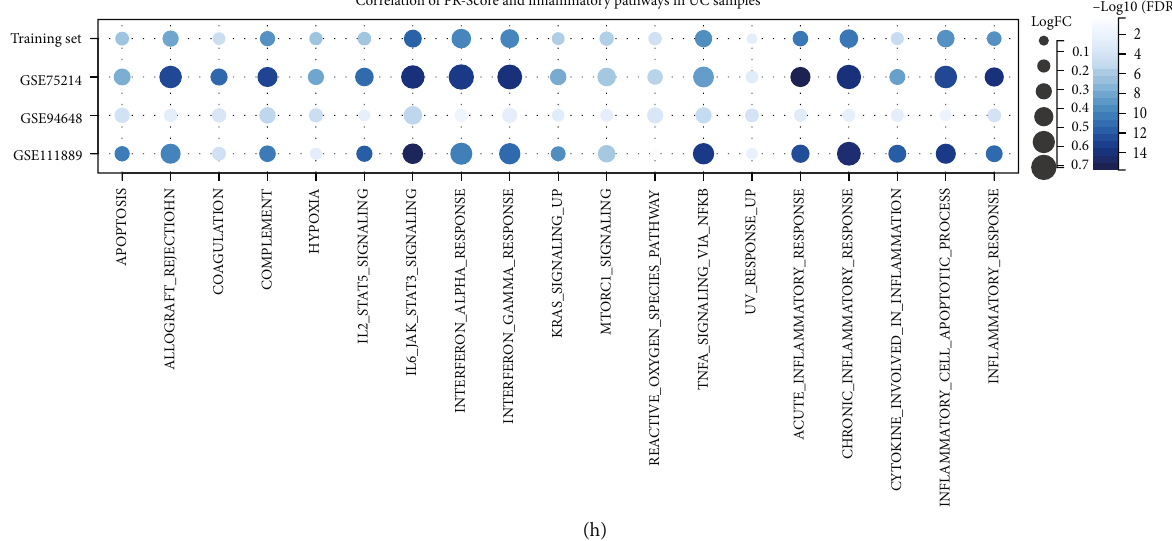
Figure 4: Correlation between PR-Score, expression of GSDM family members, and immune status. Di ff erences of the PR-Score in active UC and inactive UC samples in the training set (a), GSE75214 (b), and GSE94648 (c). (d) The ROC curve showed the diagnostic e ffi ciency of the PR-Score in three datasets. (e) The correlation of the PR-Score and Mayo score in GSE92415. (f) PR-Score was most positively associated with the expression of GSDMD in all datasets (left: the training set and GSE94648; right: GSE75214 and GSE111889). (g) Correlations of PR-Score and immune cells in UC samples in four datasets. (h) Correlations of PR-Score and in fl ammation-related pathways in UC samples in four datasets. UC: ulcerative colitis; ac: active; in: inactive; AUC: area under the curve. ∗ P < : 05 , ∗∗ P < : 01 , ∗∗∗ P < : 001 , and ∗∗∗∗ P < : 0001 . ns: not signi fi